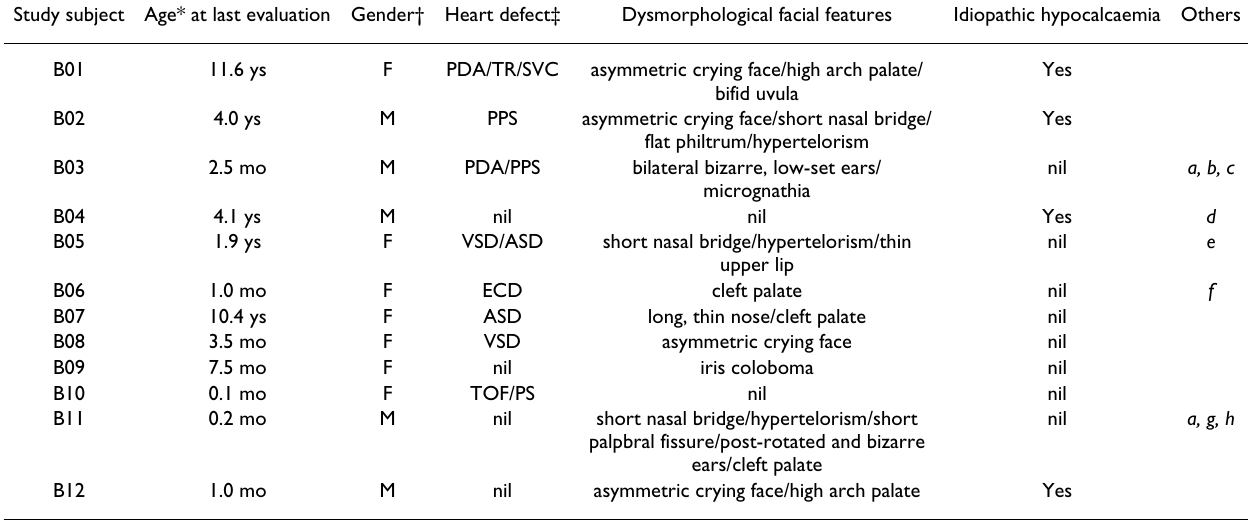
Table 1: Clinical characterization of twelve patients suspected to carry 22q11DS Study subject Age* at last evaluation Gender† Heart